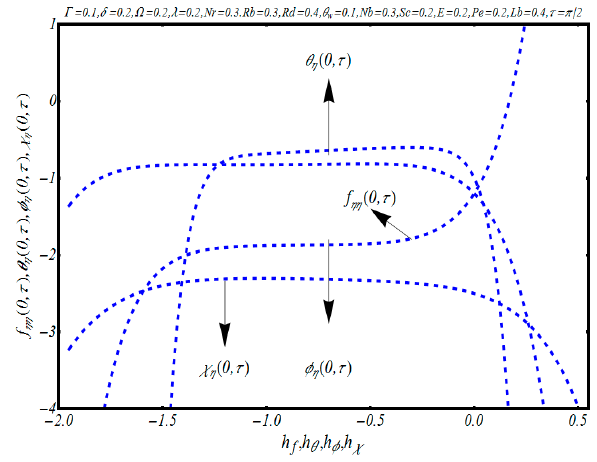
Figure 2. Curves for f ηη , θ η , φ η and χ η . Figure 2. curves for